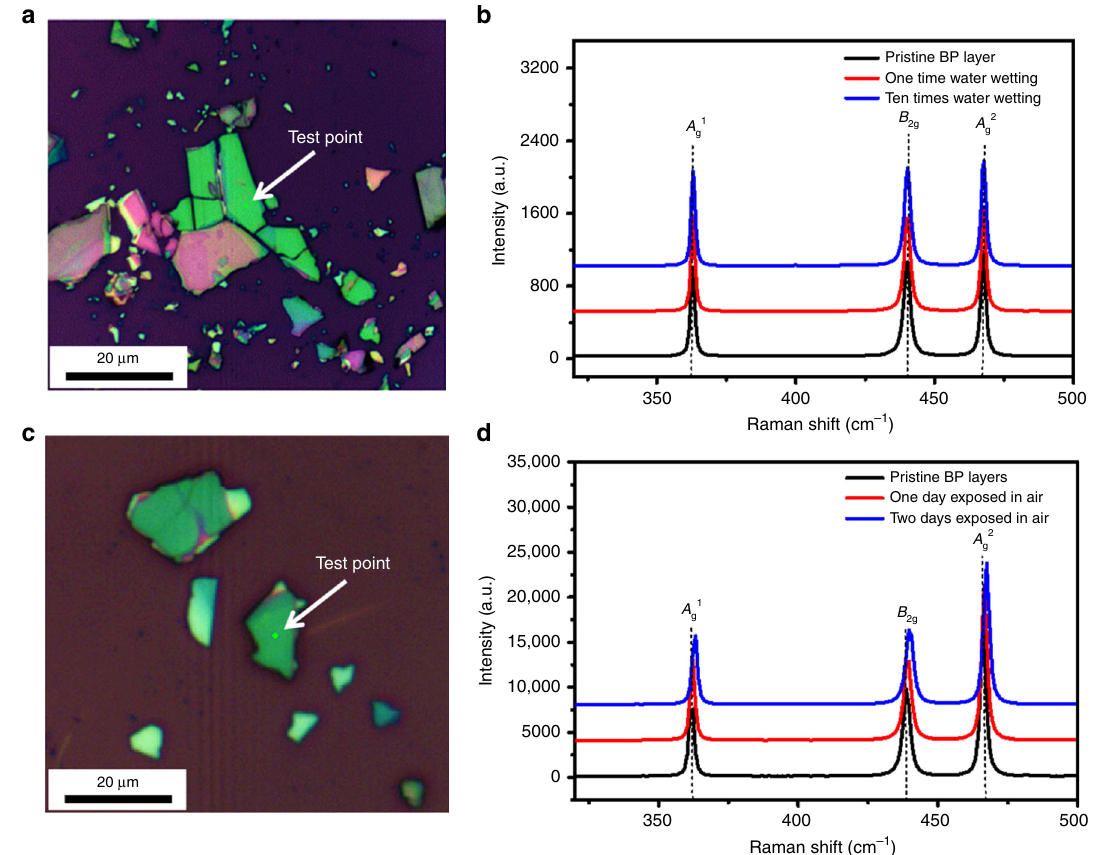
Fig. 5 In situ Raman spectroscopy test of few-layer BP. a , c Optical microscope image of BP layers, b Raman curves of BP nanosheets: pristine (black), after one water wetting experiment (red), and after ten water wetting experiments (blue), and d Raman curves for pristine BP layers and BP layers 1 and 2 days after exposure to